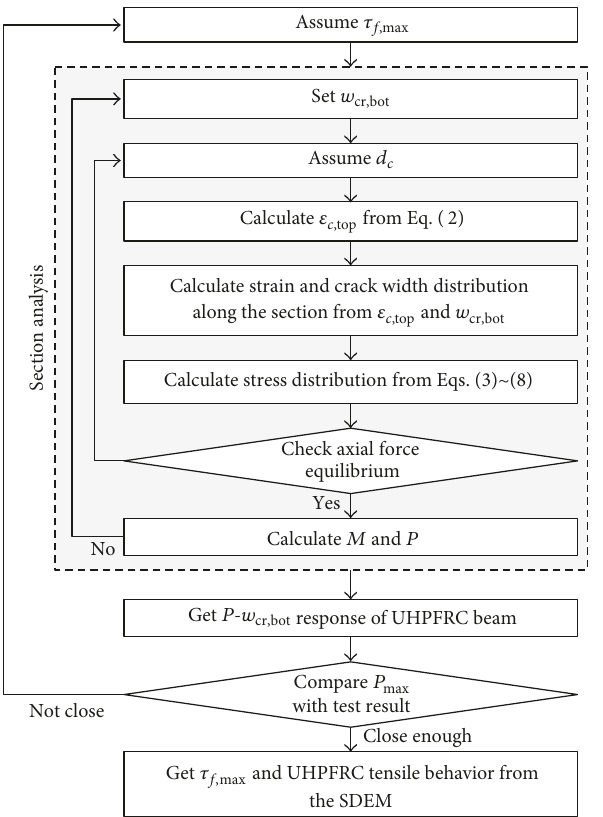
Figure 4: Analysis algorithm for the inverse analysis.